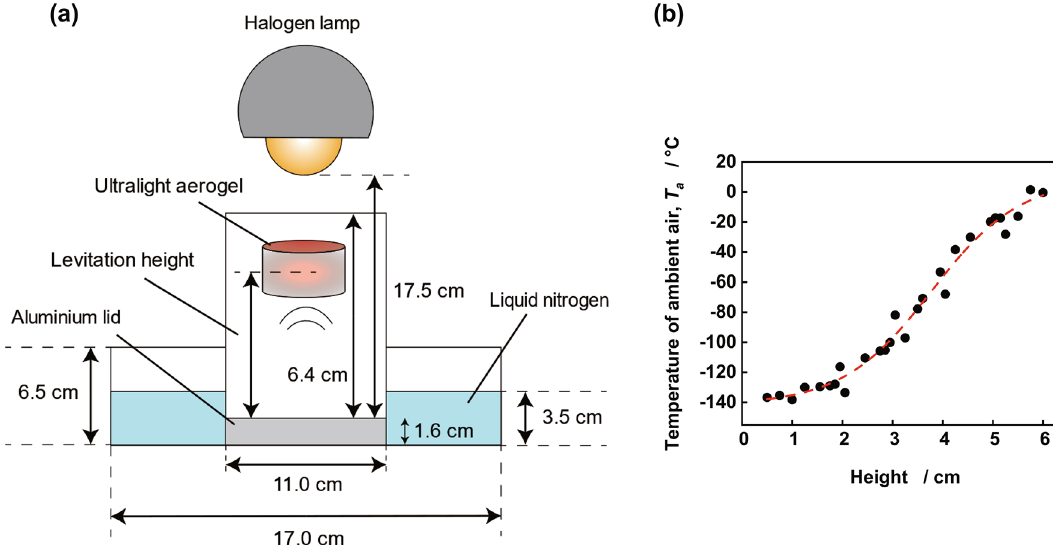
Figure 3. Setup of the levitation experiment. ( a ) Schematic diagram of the levitation experiment. ( b ) Temperature distribution in the cylinder during the levitation experiment.